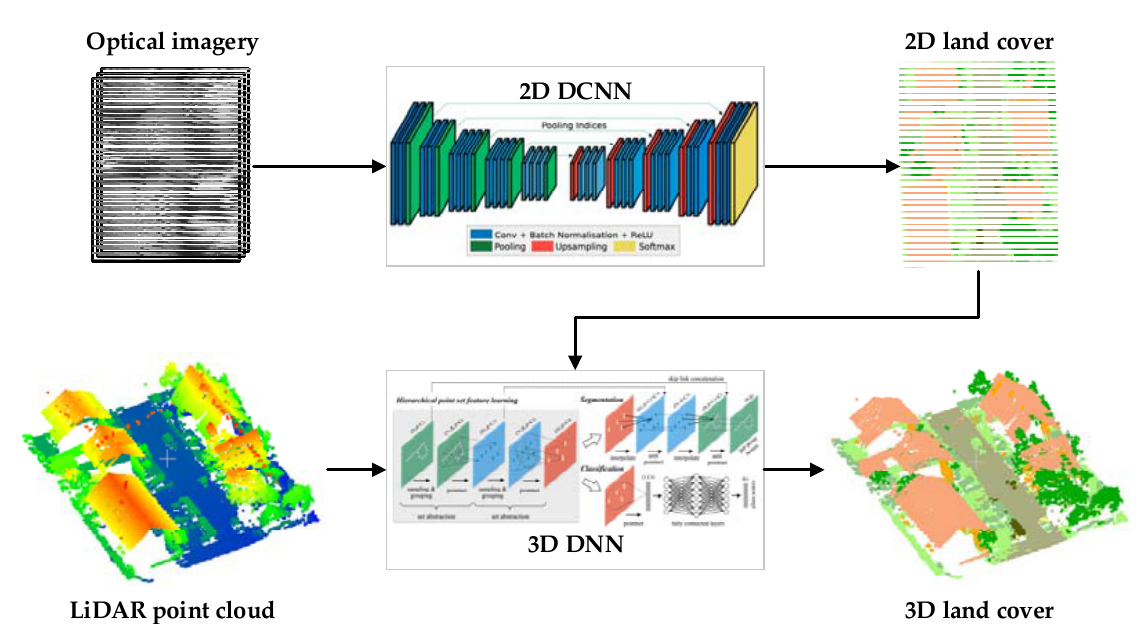
Figure 2. Framework of the proposed prior-level fusion for three-dimensional (3D) land cover classification. In this study, the two-dimensional (2D) deep convolutional neural network (DCNN) was SegNet [33] and the 3D deep neural network (DNN) was PointNet++ [34]. 2.1. Obtaining Prior Knowledge from Optical Image Using Deep Convolutional Neural Network (DCNN)